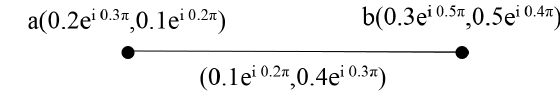
Figure 2. Complex intuitionistic fuzzy graph G 1 .